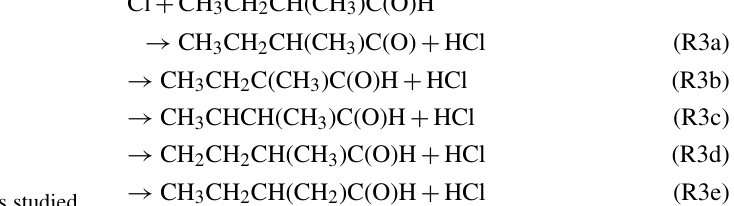
Figure 9. Relative contribution of the three removal routes studied in this work to the total diurnal